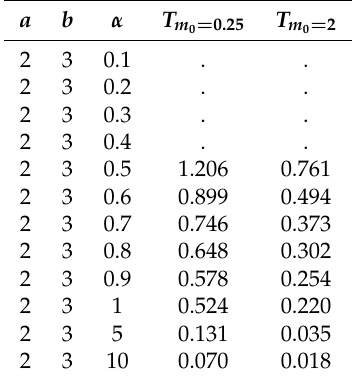
Table 3. Solvability of the ODE (52) with the states a = 2 and b =